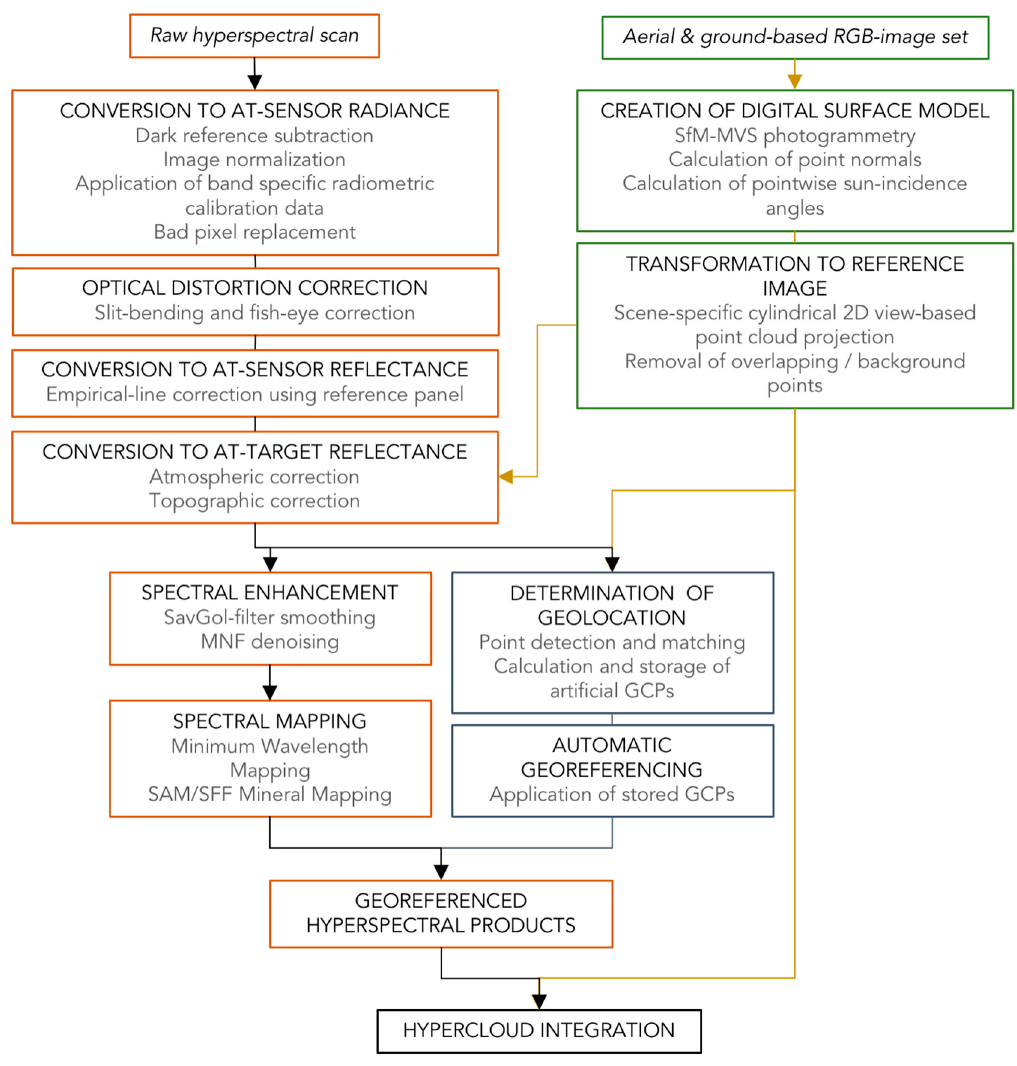
Figure 2. Schematic workflow for the correction, processing, and 3D integration of long-range ground-based hyperspectral imagery.